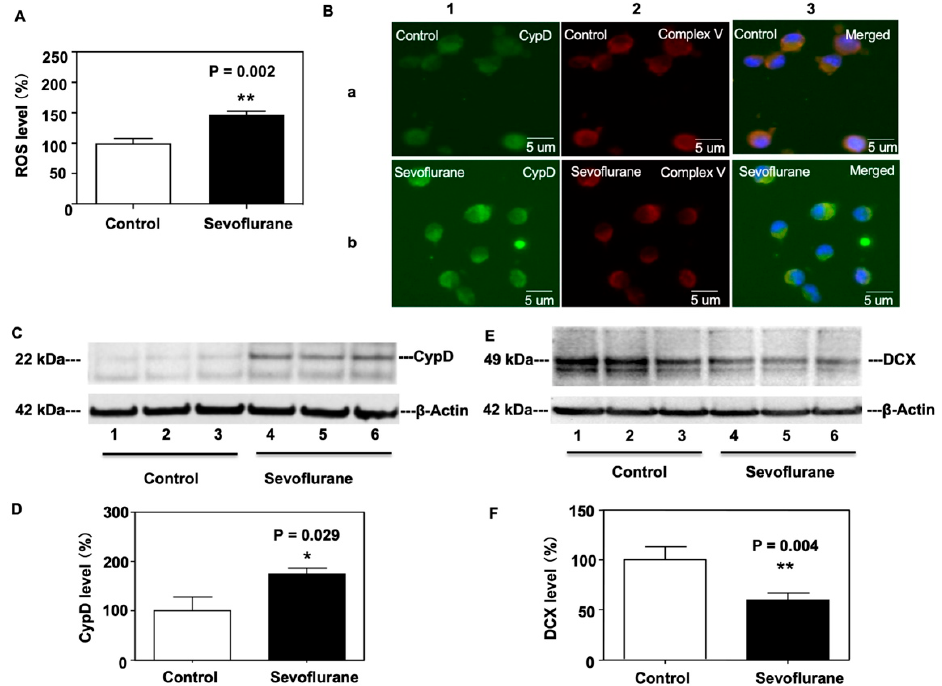
Figure 3. Sevoflurane increases ROS and CypD levels but decreases doublecortin (DCX) levels in NPCs harvested from WT mice. ( A ) Sevoflurane treatment (black bar) increases the levels of ROS compared to the control condition (white bar). ( B ) Representative images of immunofluorescent staining of CypD in NPCs harvested from WT mice. Column 1 is the CypD (green) staining, column 2 is the mitochondrial markers Complex V (red) staining, and column 3 is a merged staining image. Sevoflurane (row b) increases levels of CypD compared to the control condition (row a) in NPCs harvested from WT mice. ( C ) Western blot shows that the sevoflurane treatment (lanes 4 to 6) discernibly increases the levels of CypD compared to the control condition (lanes 1 to 3). There is no significant difference in β -actin levels between the sevoflurane treatment and control condition. ( D ) Quantitation of the Western blot illustrates increased amounts of CypD levels following the sevoflurane treatment compared to the control condition (* p = 0.029). ( E ) Sevoflurane treatment (lanes 4 to 6) discernibly decreases doublecortin (DCX) levels compared to the control condition. There is no significant difference in β -actin levels between the sevoflurane treatment and control condition. ( F ) Quantitation of the Western blot illustrates the decreased amounts of DCX levels following the sevoflurane treatment as compared to the control condition (** p = 0.004). N = 6–8 in each group. Student’s t -test was used to analyze the